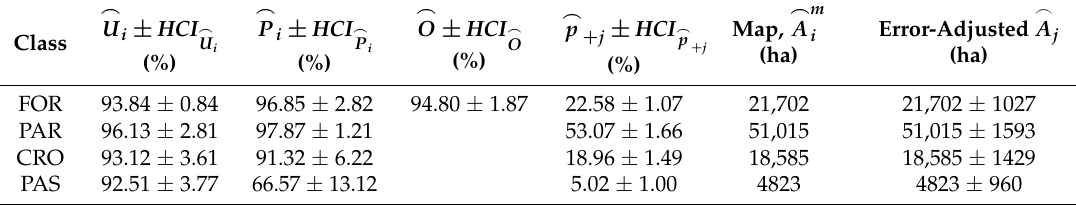
Table 7. Map accuracy and incertitude assessment of the areas.